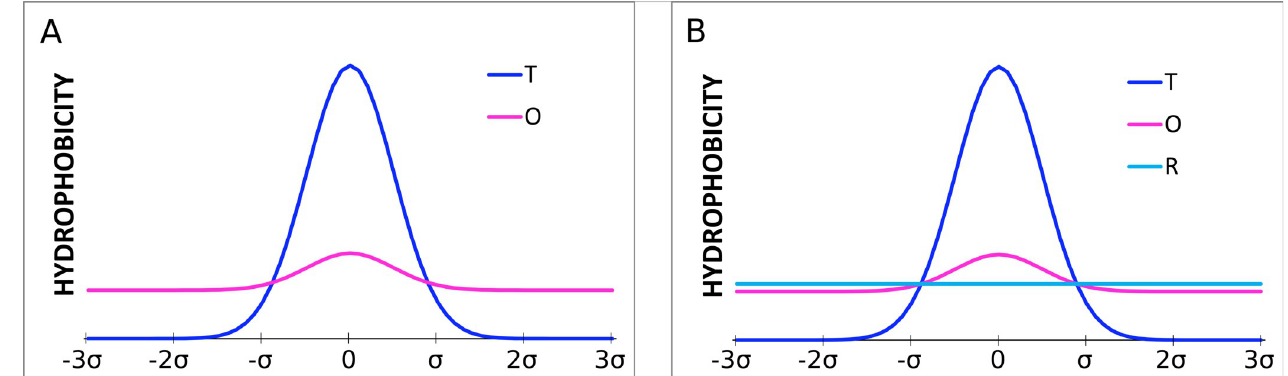
Fig 10. Examples of distributions. A–distribution O (pink) and reference Gaussian distribution T (with parameter σ ) expressing the presence of the central hydrophobic core (dark blue). B–the second reference distribution R (light blue) superimposed—expressing the lacking of any variation in the hydrophobicity.